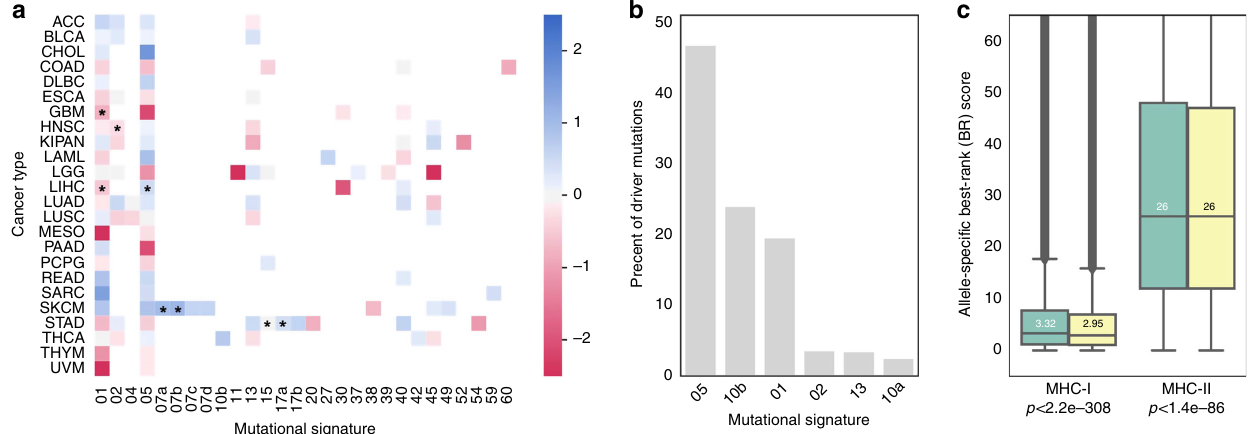
Fig. 3 Sex-speci fi c exposure analysis with mutational signatures. a Heatmap of log2 male (blue) to female (pink) ratios of mutational signatures for each tumor type with asterisks denoting a signi fi cantly different ratio between male and female sexes. b The percentage of mutations in the set of driver mutations that are part of each mutational signature. c Boxplot comparing MHC-I and MHC-II presentation scores across all possible alleles for C>T or T>C driver mutations (green) versus driver mutations resulting from other base substitutions (yellow); 1,063,975 and 2,051,300 af fi nity scores were evaluated for C>T or T>C mutations for class I and II, respectively; and 1,851,025 and 3,568,700 af fi nity scores were evaluated for other mutations for class I and II, respectively. Exact p values were calculated using a one-tailed Mann – Whitney U test: ( c ) 2.2e − 308 and ( d ) 1.4e − 86. Median values are denoted in each boxplot. All box plots include the median line, the box denotes the interquartile range (IQR), whiskers denote the rest of the data distribution and outliers are denoted by points greater than ±1.5 × higher PHBR scores (i.e., worse presentation) leading to higher probability of mutation (Supplementary Table 3). While PHBR- II:sex and PHBR-II:age coef fi cients trended in the same direction, with stronger effects in females and younger patients, they did not reach signi fi cance, likely due to sample size.